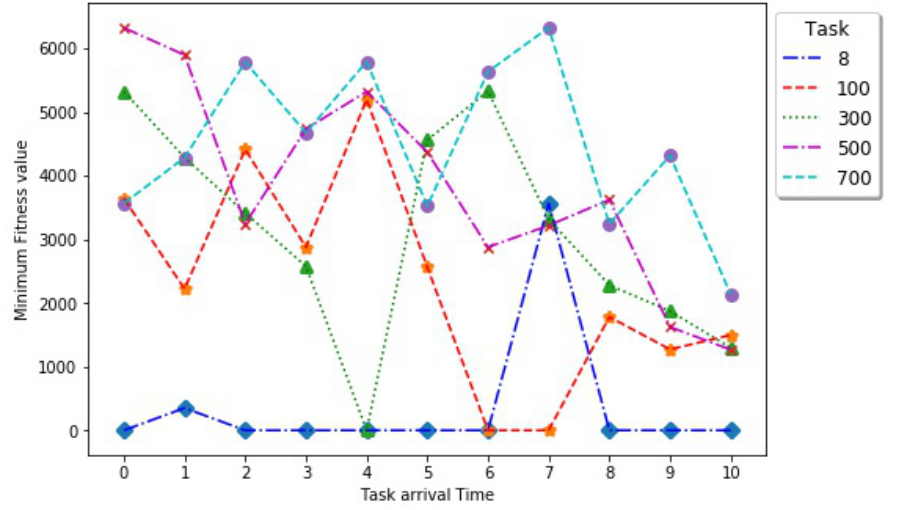
Figure 15. Minimum fitness value of tasks with arrival time